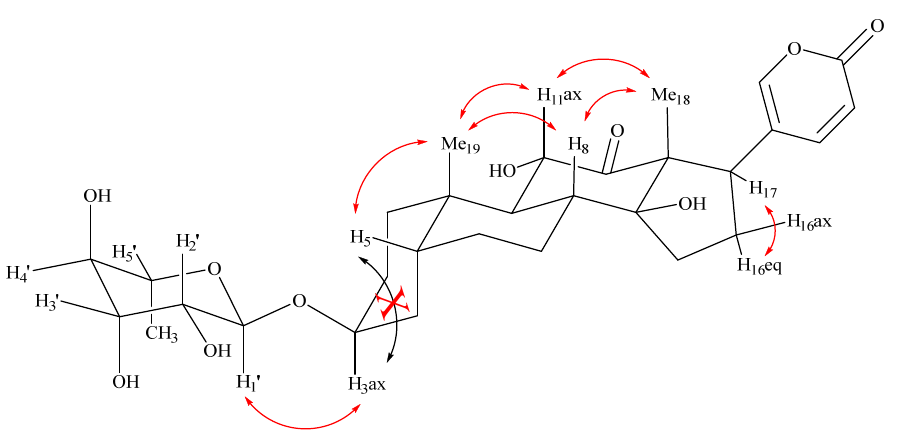
Figure 2. NOESY correlations in compound 4 . Table 1. Acaricidal effect of the isolated compounds and Drimia pancration extract against Tetranychus urticae females 96 h after